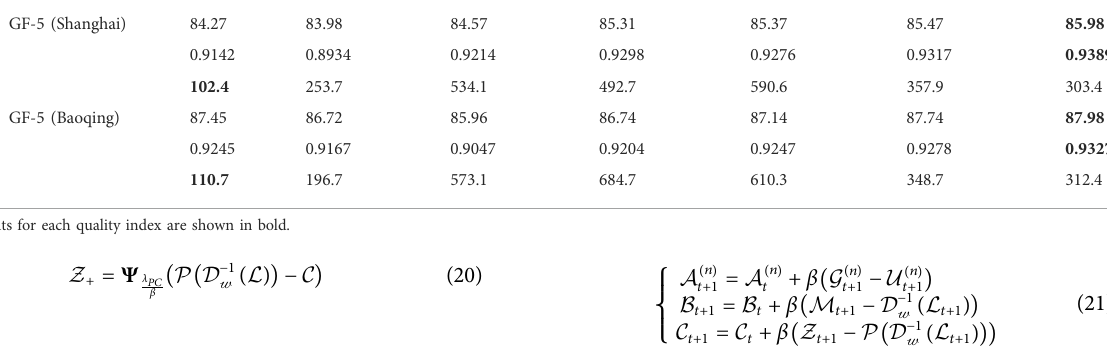
The speci fi c process of the ADMM-based solver for the ATRFHS HSI reconstruction model and BCD-based solver for auto-weighting is introduced in Algorithm 1.